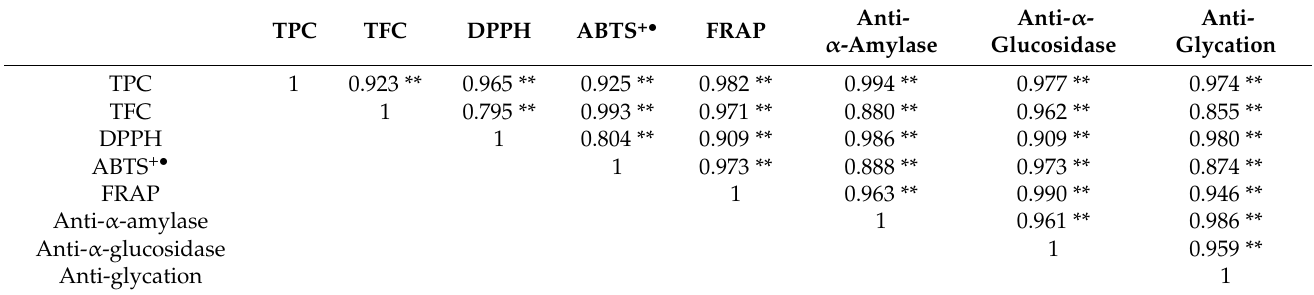
Table 6. Correlation among TPC, TFC, DPPH, ABTS + • , FRAP assay, anti- α -amylase, anti- α -glucosidase and anti-glycation of SPE in Eri